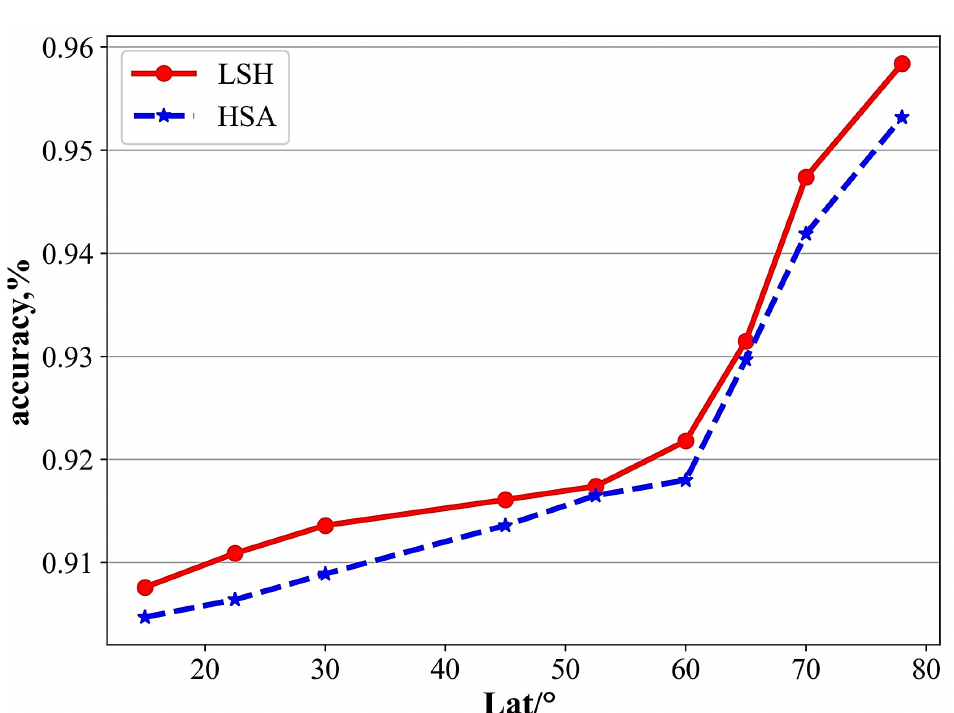
Figure 13. Comparison of prediction accuracy between LSA periods and HSA periods in different